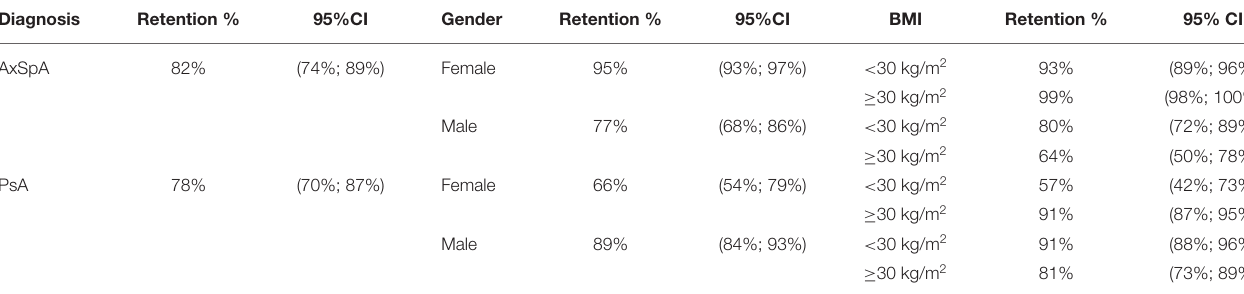
TABLE 4 | Estimated retention rate during the 1st year of secukinumab treatment according to diagnosis, gender, and BMI. Diagnosis